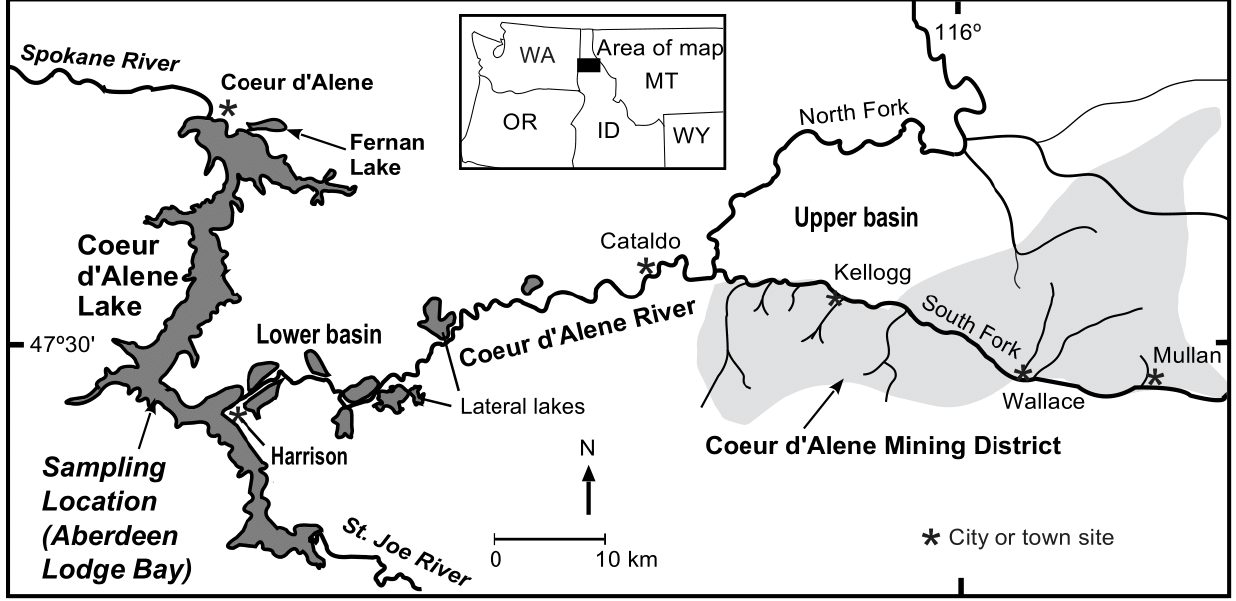
Figure 1. Coeur d’Alene Lake, River, and Mining District (Silver Valley) in northern Idaho, USA (modified from [21] ).